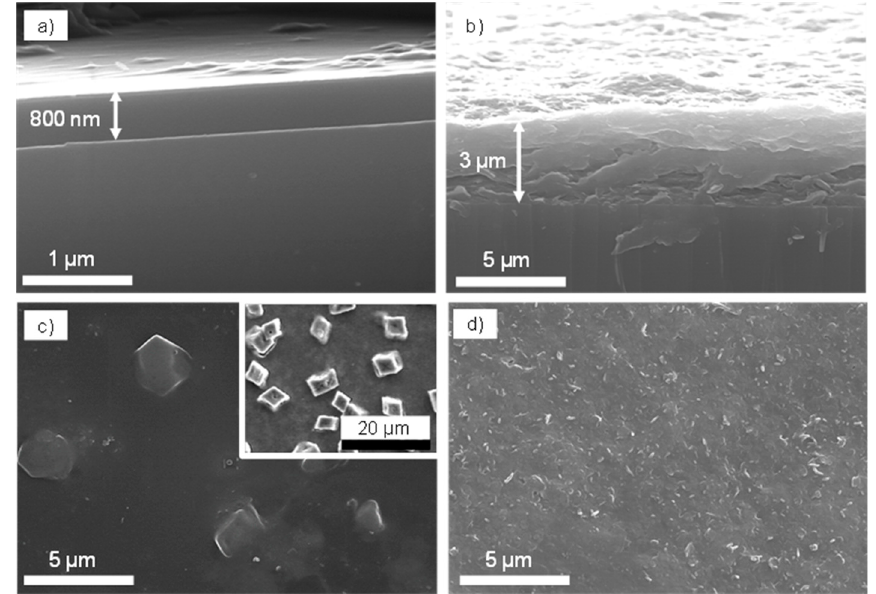
Figure 8. SEM images of layers of the Co 2 Al–NO 3 LDH crystallites deposited on glass substrates with ( a , c ) and without ( b , d ) application of an external magnetic field; cross section views ( a , b ) and top views ( c , d ). Inset shows the regular-shape particles of Co 2 Al–NO 3 formed on the surface of dense LDH film.